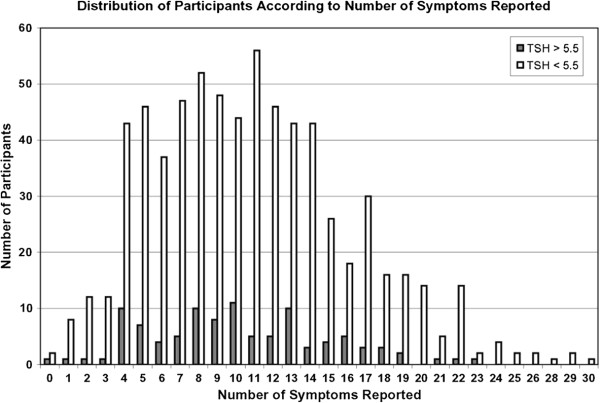
Distribution of participants according to number of symptoms reported.